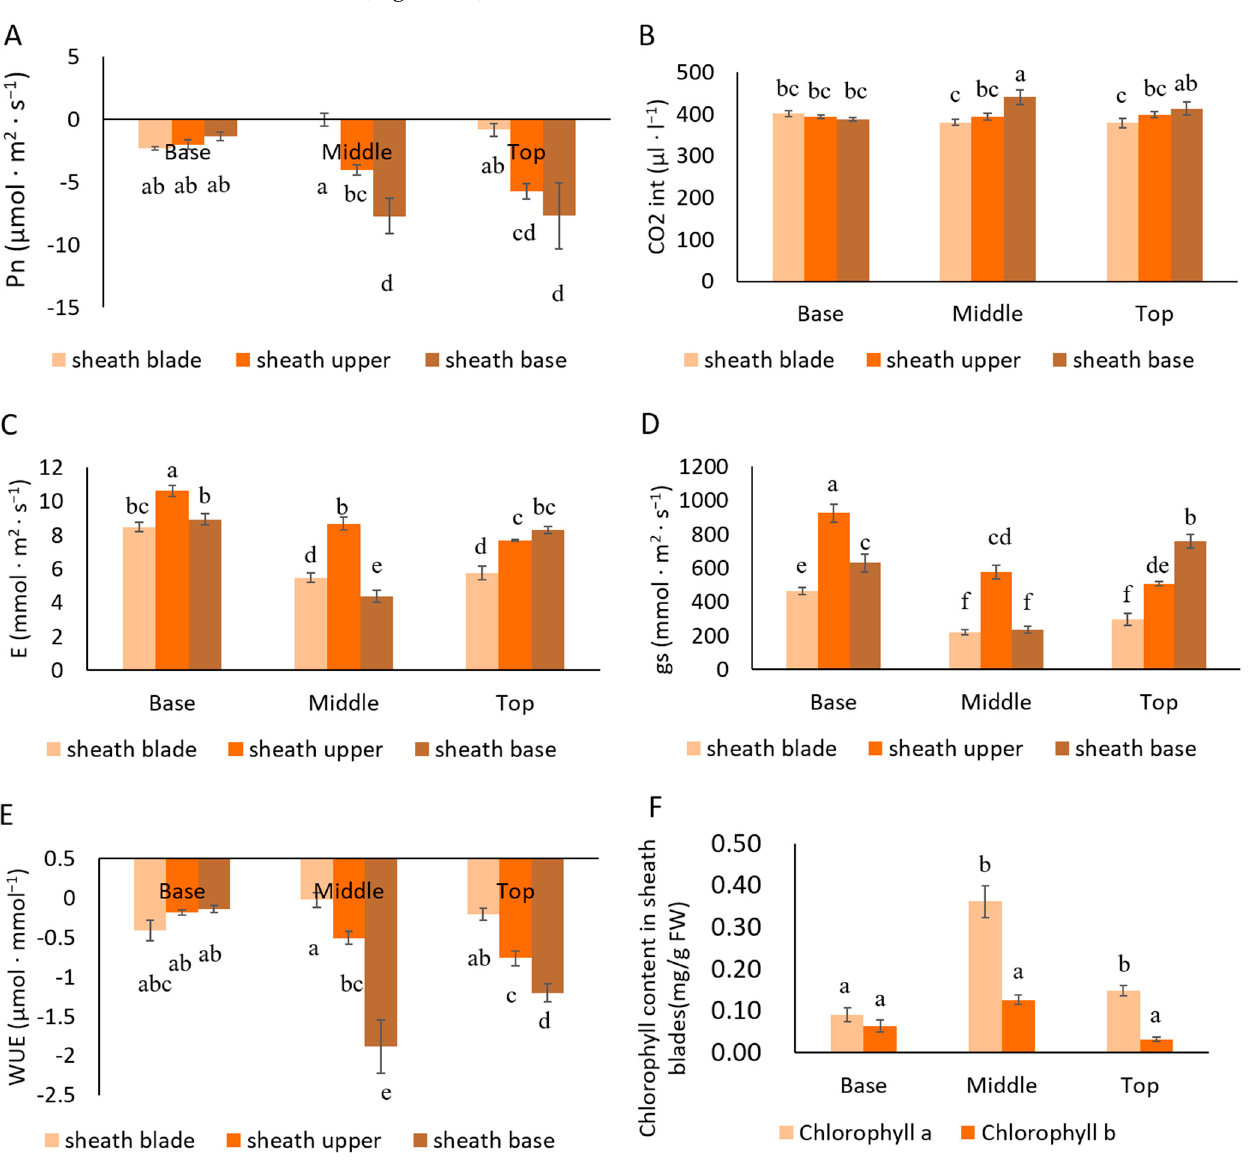
Figure 2. Gas exchange parameters of bamboo sheaths and chlorophyll content in sheath blades. ( A ) Pn: net photosynthetic rate. ( B ) CO 2int : intercellular CO 2 concentration. ( C ) E: transpiration rates. ( D ) gs: stomatal conductance. ( E ) WUE: water-use efficiency. ( F ) Chlorophyll content in different parts. The experiments were repeated three times. Different letters indicate significant differences ( p < 0.05).